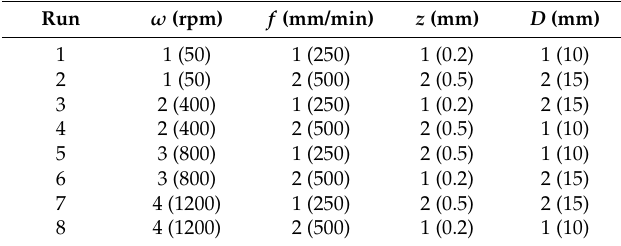
Table 3. Orthogonal array L8 (4 1 . 2 3 ) of the experimental runs.